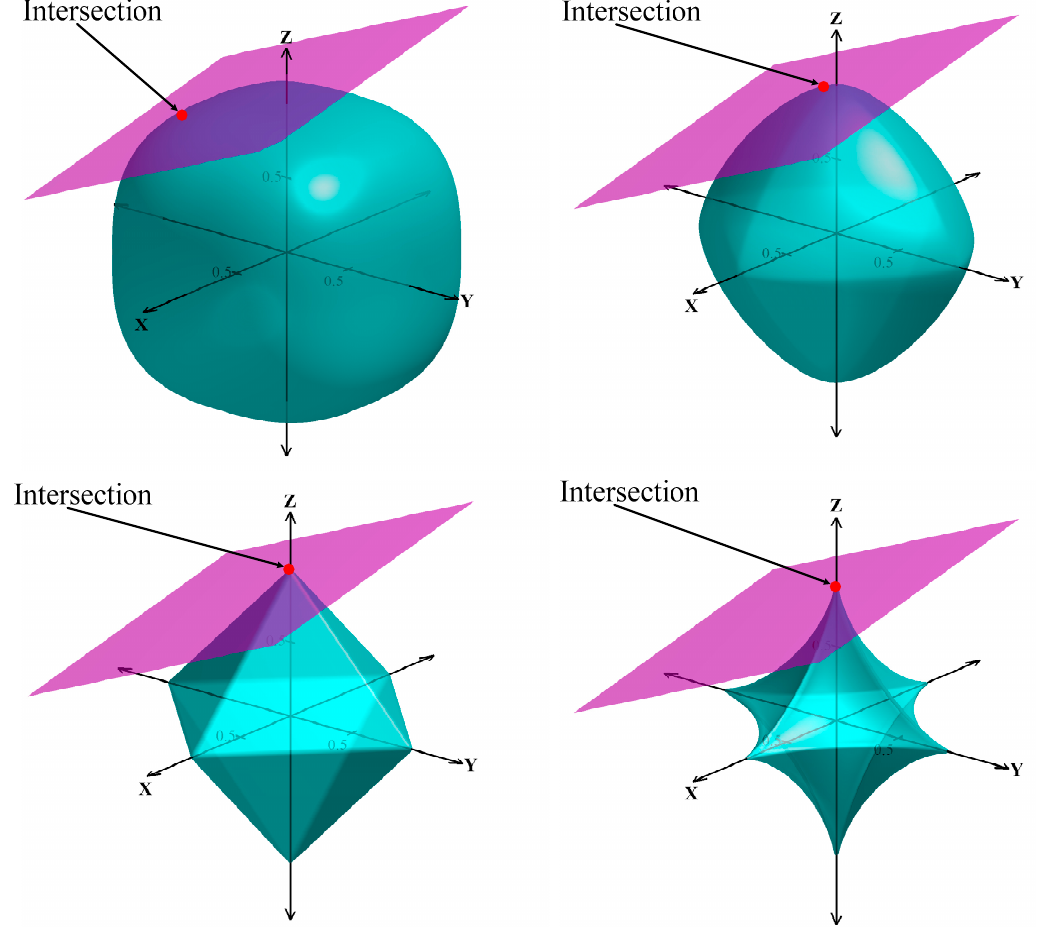
Figure 1. Geometry with different p values. From left top to right bottom, p equals to 2.8, 1.4, 1, 0.7, respectively.